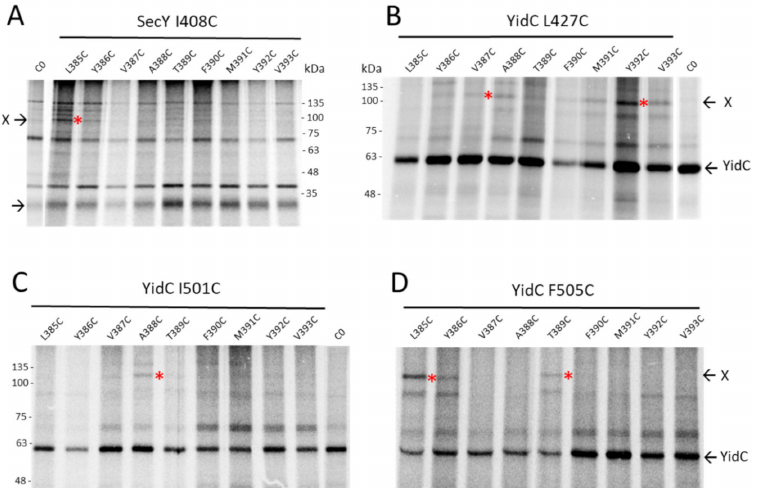
Figure 6. The transmembrane anchor region of G3p interacts with SecY and YidC. ( A – D ) The core of the G3p membrane anchor (residues 385–393) was scanned for interactions by single cysteines at these positions. ( A ) Coexpression of the G3p mutants with SecYEG with a single cysteine at position 408 in TM10 of SecY in E. coli MG1655-SecE. The cells were treated as described in Figure 5 but immunoprecipitated with an antibody to the T7-tag. ( B – D ) Coexpression of the G3p mutants with YidC in E. coli MK6 grown without arabinose. The plasmid-encoded YidC had a cysteine at residue 427 in TM3 (B), 501 ( C ) or 505 ( D ) in TM5, respectively. The cells were treated as described in Figure 5 but immunoprecipitated with an YidC antiserum. The potential crosslink products are marked with red asterisks.